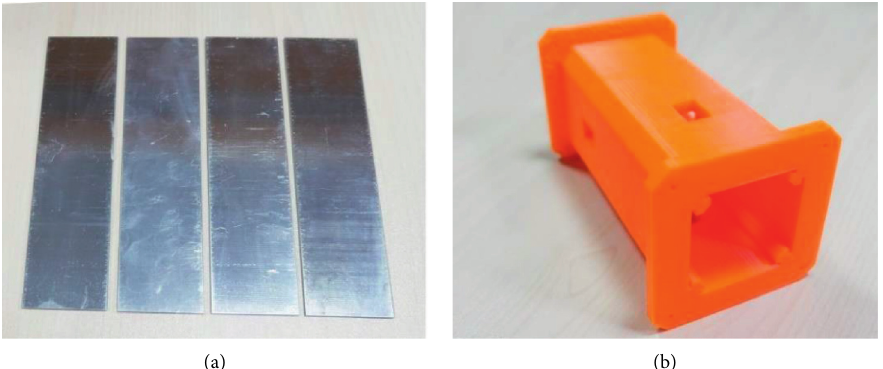
Figure 9: (a) Electrodes customised by the printed circuit board and (b) gas flow tube fabricated by the 3D printer.